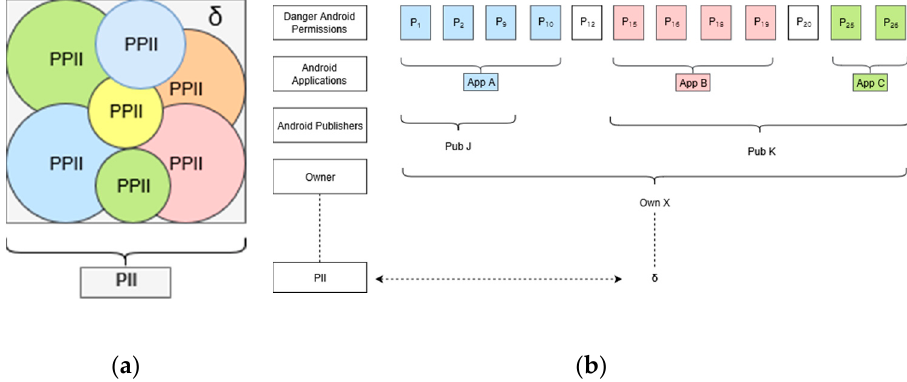
Figure 4. ( a ) PII generation from a set of PPII and ( b ) PII generation from aggregated permissions.